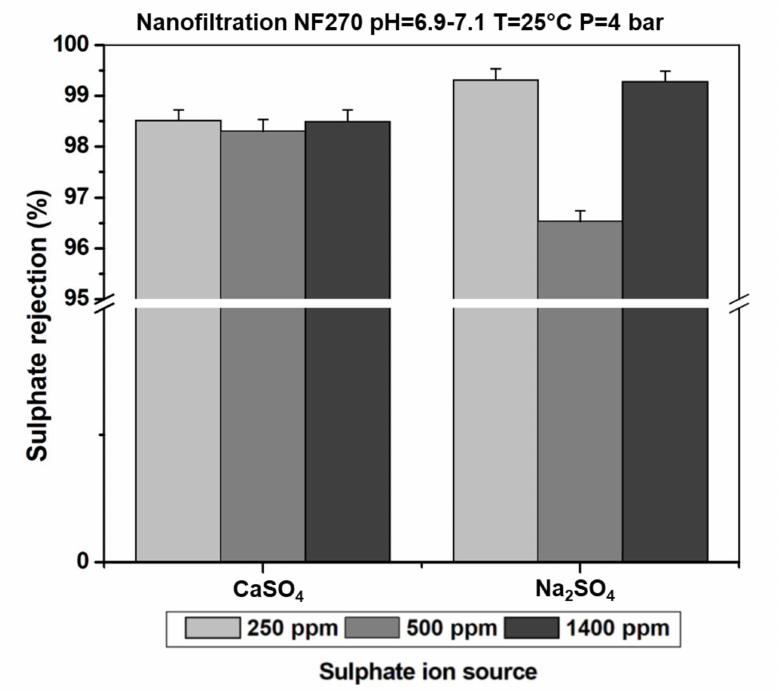
Figure 4. Effect of the sulphate ion concentration in feeding solutions on the rejection rate with the nanofiltration NF270 membrane.